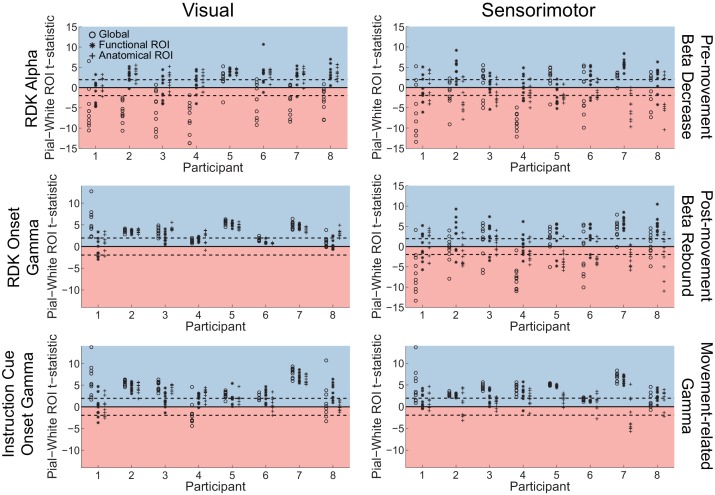
Adding coregistration error biases visual and sensorimotor laminar specificity to the pial surface.Each panel shows the t-statistics comparing the unsigned magnitude of the change in power between the pial and white matter surfaces averaged within the regions of interests (ROIs), over all participants. T-statistics for the whole brain (circles), functionally defined (asterisks), and anatomically-constrained (crosses) ROIs are shown for 10 random fiducial coordinate perturbations involving a random translation (magnitude M = 10 mm, SD = 2.5 mm) and rotation (magnitude M = 10°, SD = 2.5°). These perturbations are within the range of commonly observed head movement with standard MEG recordings (Singh et al., 1997; Hillebrand and Barnes, 2011; Stolk et al., 2013; Troebinger et al., 2014b), but well above the head movement recorded in the present study. Red background indicates a bias towards the white matter surface, and blue background a bias towards the pial surface. The dashed lines indicate single participant-level significance thresholds.